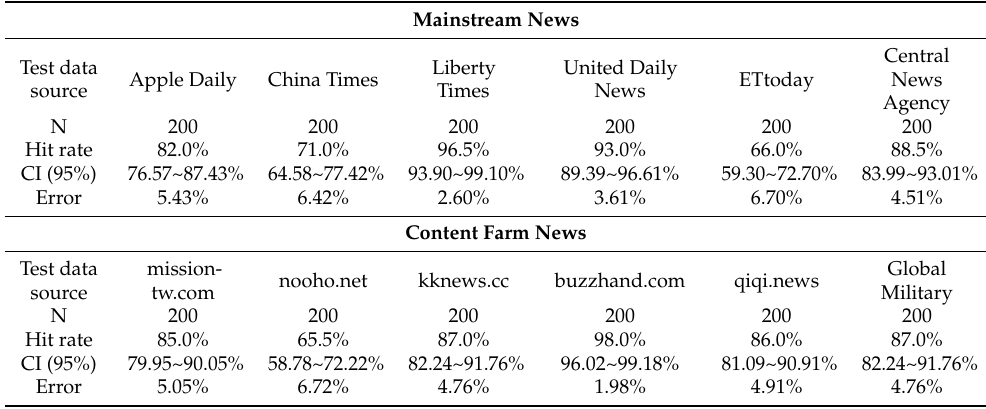
Table 2. The result of the ANN method for mainstream news and content farm